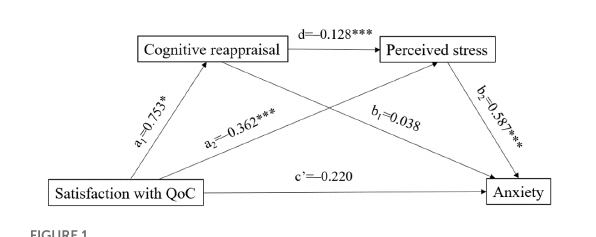
FIGURE 1 The chain mediation analyses of cognitive reappraisal and perceived stress on anxiety (ADL disability of the residents, age of the family members, and expressive suppression were included as covariates. QoC, quality of care, * p < 0.05, *** p < 0.001).